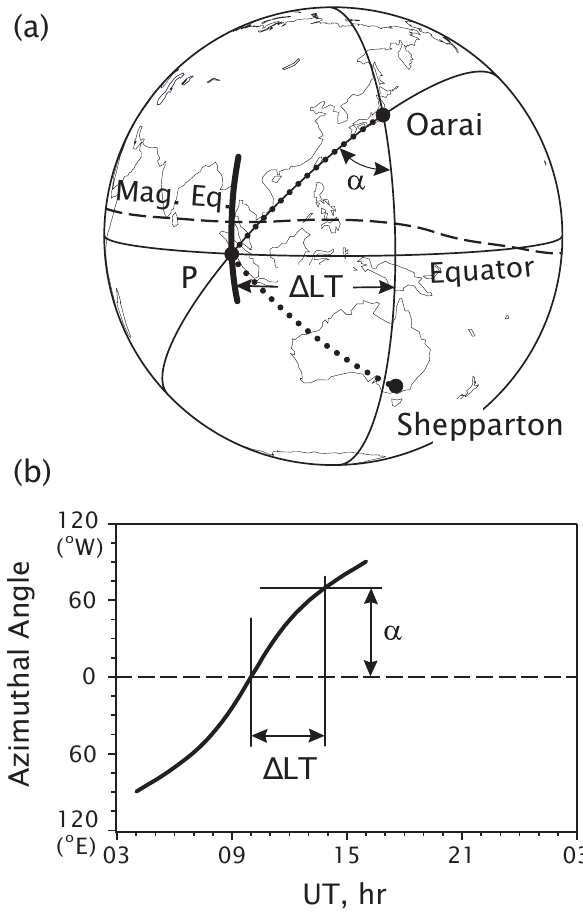
Fig. 6. Relationship between the direction of arrival of the incident ray ( α) and the reflection point (P) at the geographic equator. The dotted curve represents the ray path reaching